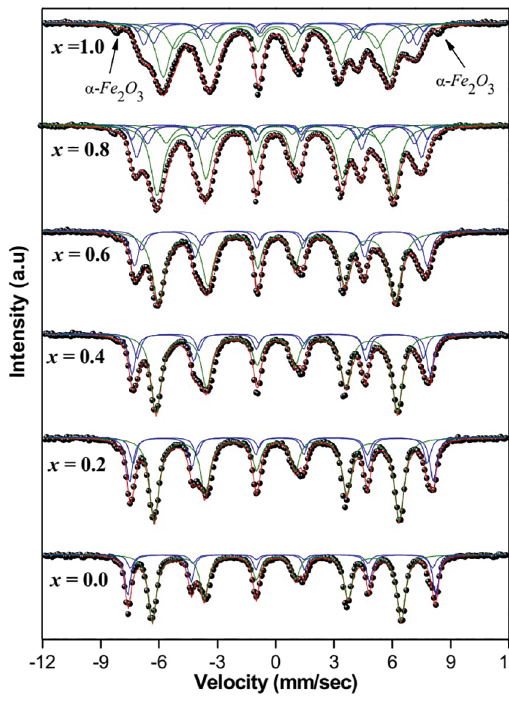
Al Fe O samples ( filled 3 x 5- x 12